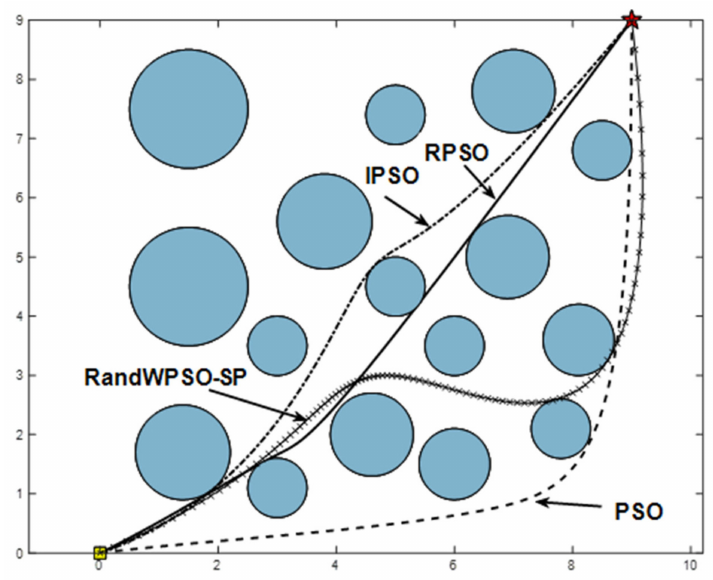
Figure 3. Comparison of path